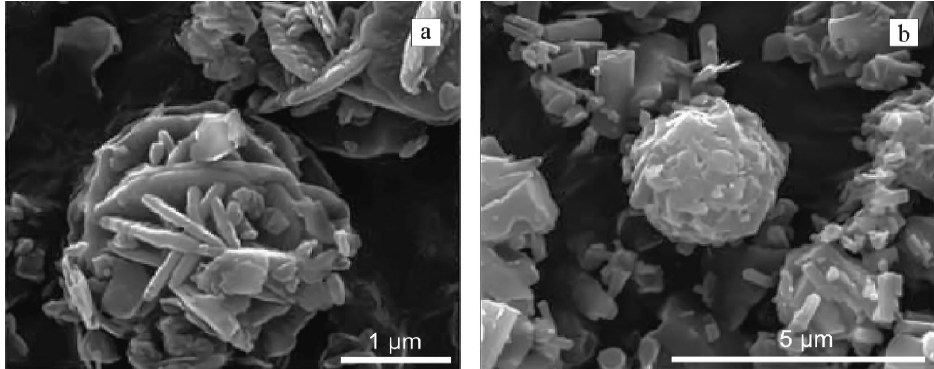
Figure 4. Alkaline alteration products formed during the ageing of kaolinite in 5 M NaOH + 4 M SO 4 at 70 °C for ( a ) 2 days, ( b ) 7 days (reproduced after the Figure 3 of [20] with the permission of the Mineralogical Society of Great Britain and Ireland).